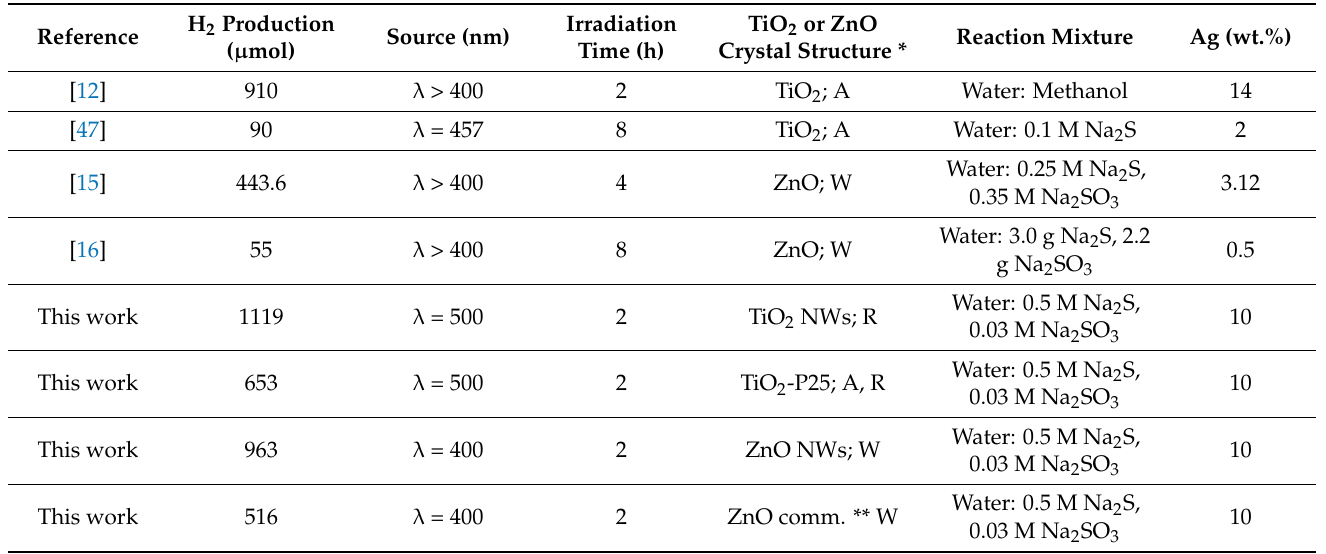
Table 5. Recent works for photocatalytic hydrogen production using Ag@TiO 2 and Ag@ZnO catalysts.